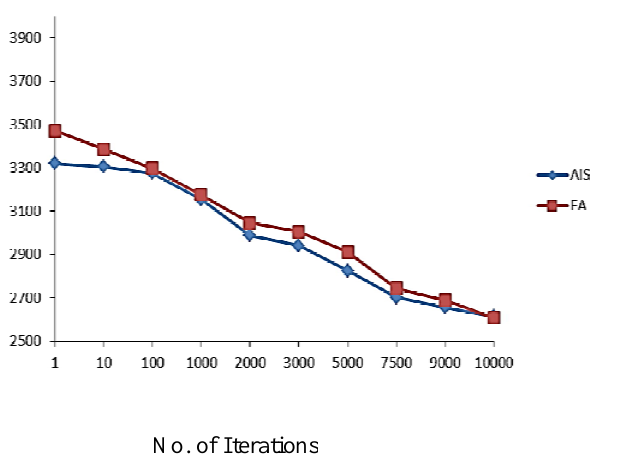
Fig.7 – Convergence graph for 30×10 variable sublot sizes problem (makespan performance results)